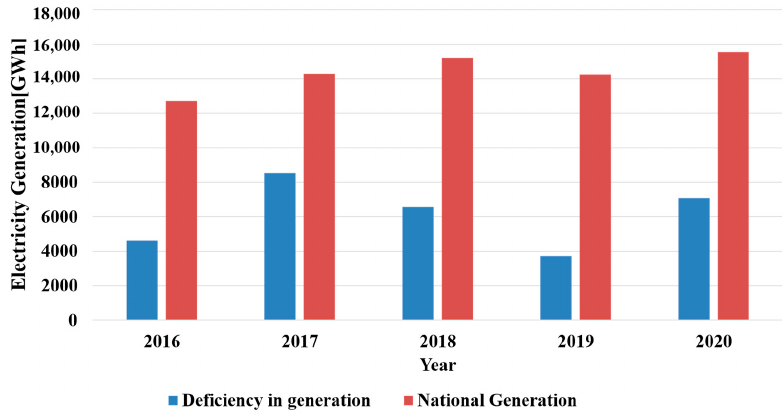
Figure 2. The trend of electricity generation and deficiency in